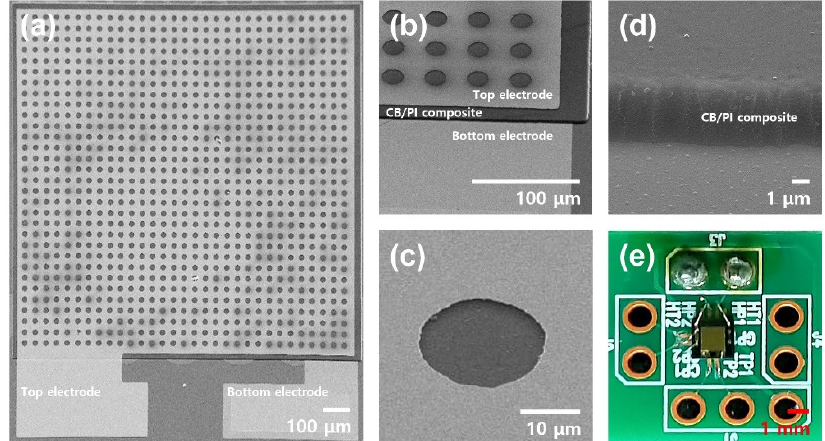
Figure 3. SEM images of the ( a ) fabricated humidity sensor, ( b ) top electrode/sensing dielectric layer/bottom electrode stack, ( c ) hole pattern in the top electrode, and ( d ) carbon black/polyimide composite after photolithography patterning. The humidity sensor mounted on a PCB is shown in ( e ).